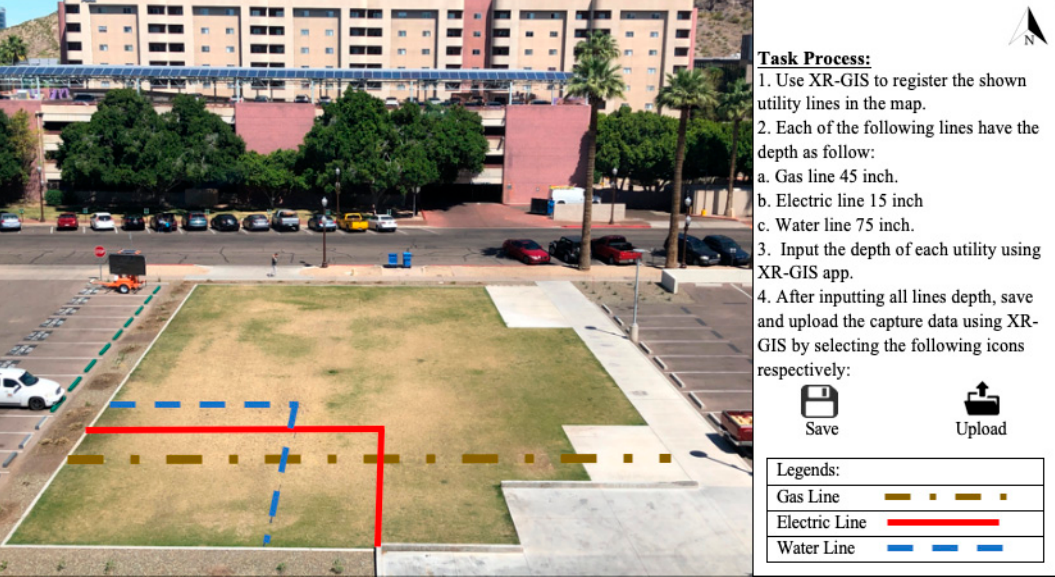
Table 2. Confirmatory focus group questionnaire.